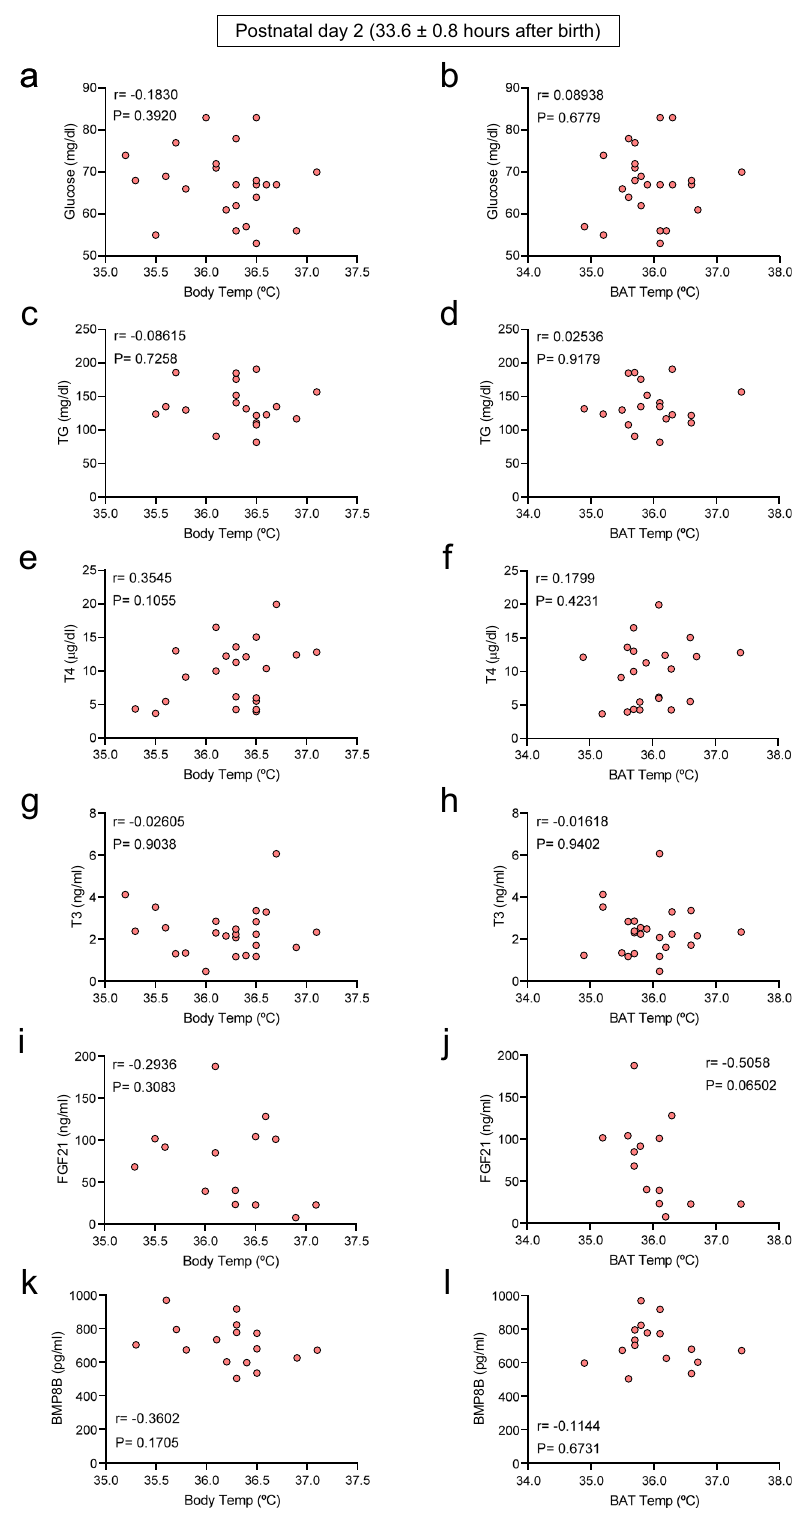
Fig. 5 Correlations between body and BAT temperatures and circulating parameters in control 2-day old newborns. Correlation between body temperature ( a , c , e , g , i , k ) and BAT temperature ( b , d , f , h , j , l ) in newborns in control conditions at postnatal day 2. Number of newborns: a 24, b 24, c 19, d 19, e 22, f 22, g 24, h 24, i 14, j 14, k 16, and l 16. Association analysis was performed by two-sided Pearson ’ s or Spearman ’ s tests. Source data are provided as a Source data fi